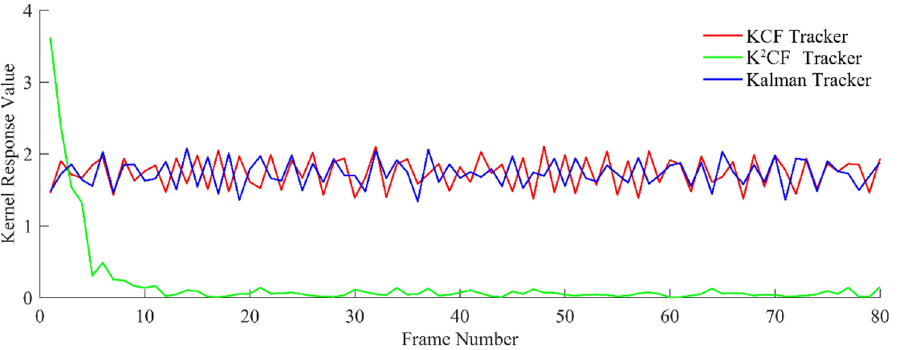
Figure 12. Output detection value of uniform state.